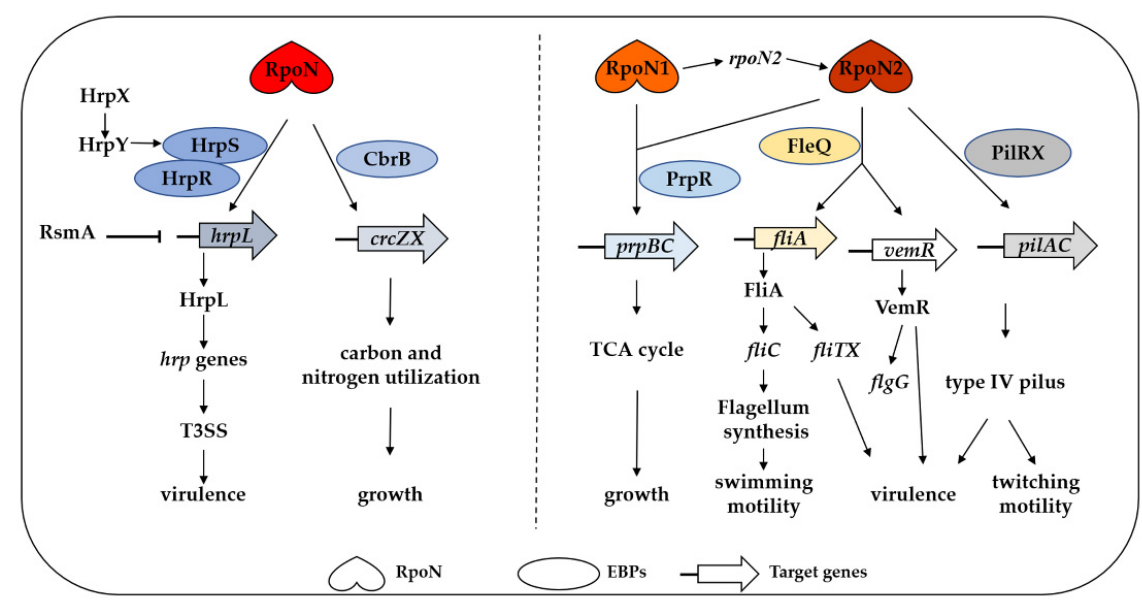
Figure 4. The regulatory functions of RpoN in major phytopathogenic bacteria. Left, P. syringae containing a single RpoN. RpoN requires HrpS and HrpR to activate HrpL-dependent transcription of T3SS, thereby regulating virulence. The two-component system HrpXY and RsmA is involved in the T3SS gene expression by positively regulating hrpS and negatively regulating hrpL . It also regulates crcZX by binding with CbrB and regulates bacterial growth by affecting carbon and nitrogen utilization. Right, Xanthomonas containing two copies of RpoN factors, RpoN1 and RpoN2, with unique and overlapping regulatory roles. RpoN2 regulates the synthesis of flagellum and T4P by interacting with FleQ and PilRX, respectively. It also depends on FleQ to regulate the fliTX and vemR expression and positively regulate bacterial virulence. Both RpoN1 and RpoN2 are involved in the regulation of bacterial growth by interacting with PrpR. In addition, RpoN1, along with unknown EBP, indirectly regulates the RpoN2 transcription.